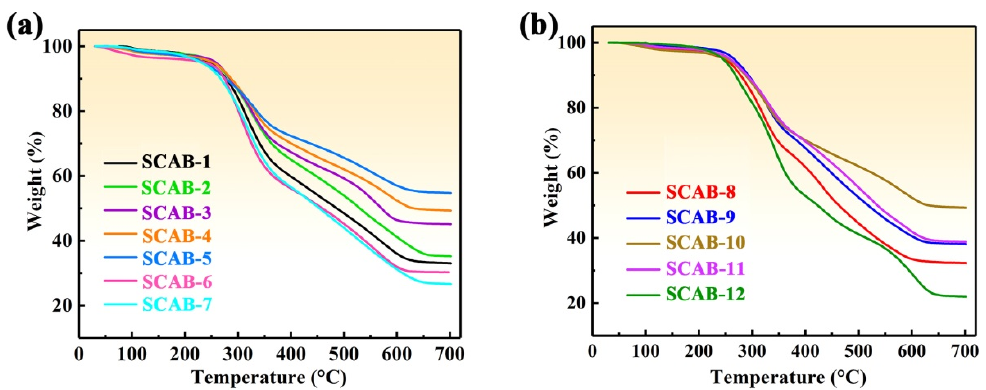
Figure 8. ( a ) Thermogravimetric analysis (TGA) curve of SCAB 1–7. ( b ) TGA curve of SCAB 8–12.